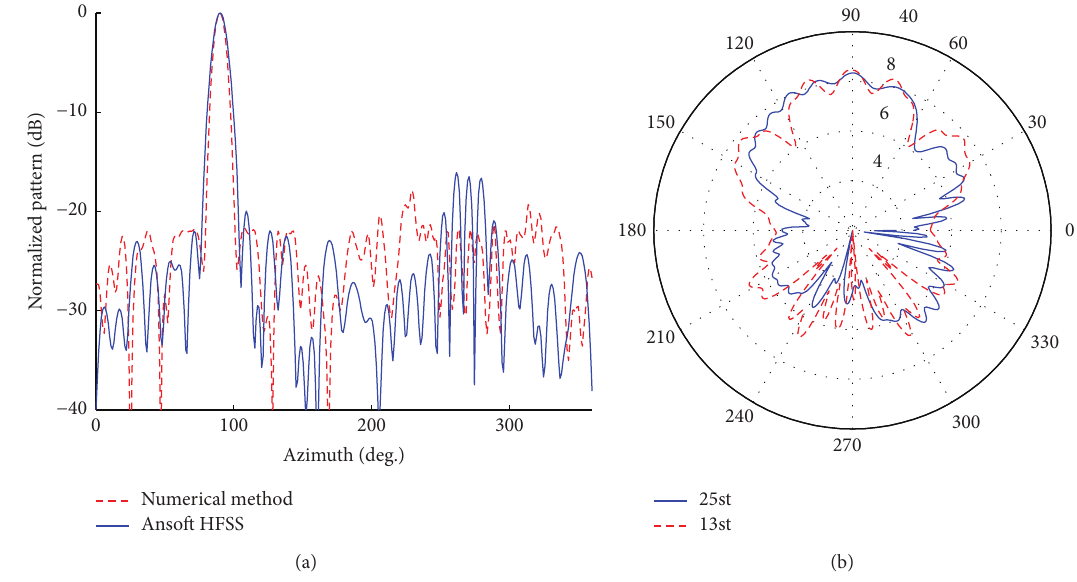
Figure 10: (a) Comparison from Ansoft HFSS and numerical simulation. (b) Difference between 13th and 25th